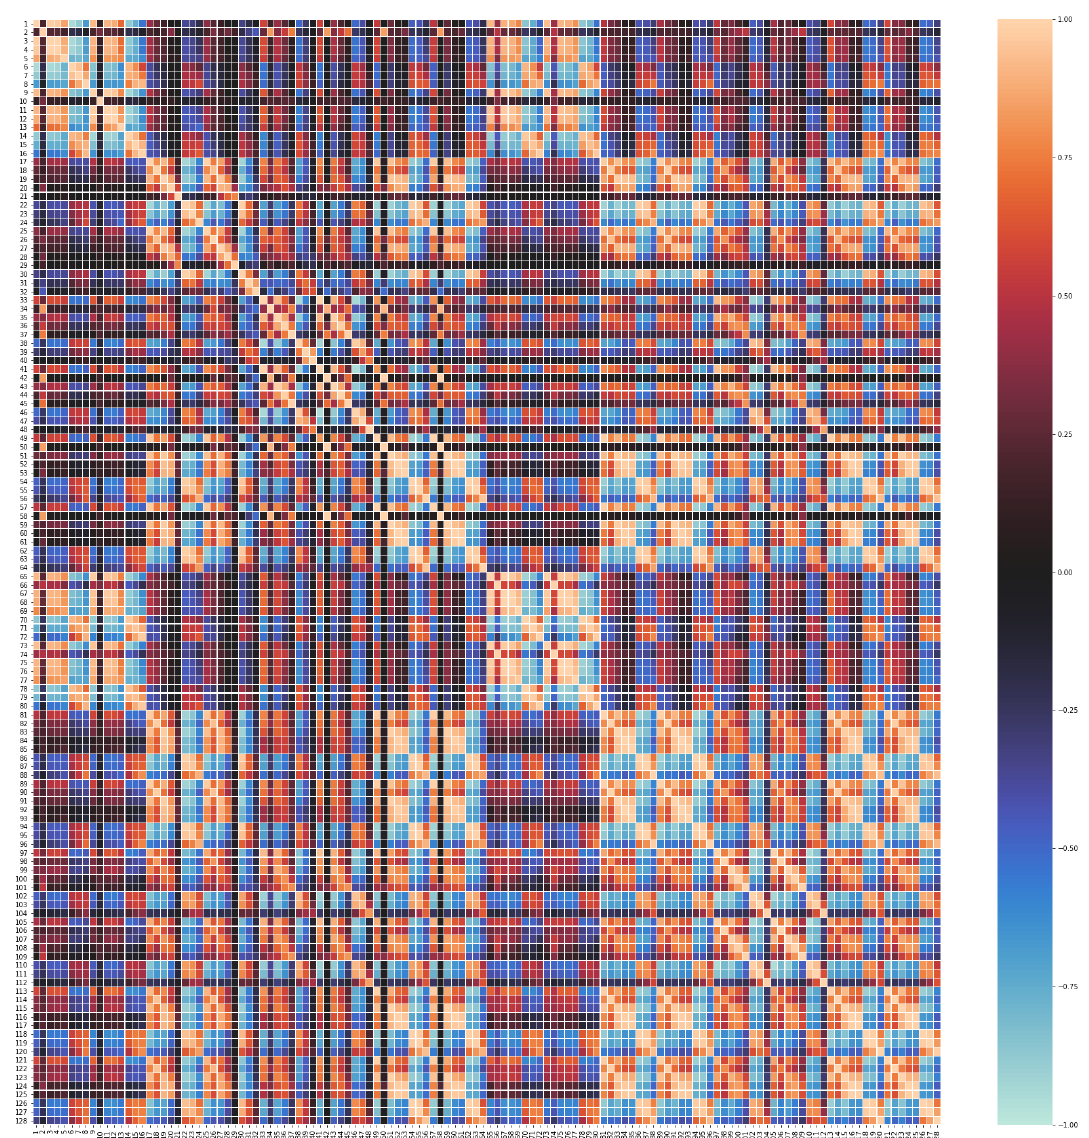
Figure 6. Correlation matrix for the 128 sensors in the [40] dataset. Warm colors (with maximum light orange) stand for strong positive correlation and cool colors (with maximum light blue) mean strong negative correlation. Black indicates no linear